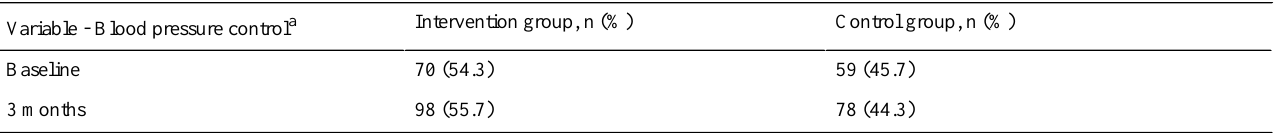
Table 6. Secondary outcome at the 3-month